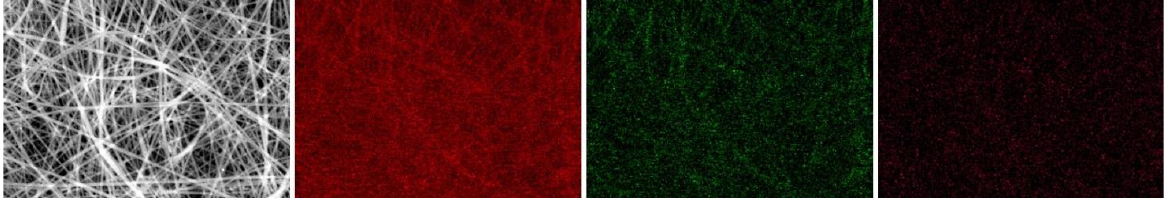
Figure 5. S E M-EDX images of PAN-PMMA fibers. The distribution of carbon atoms (in red), nitro- gen (in green), and oxygen (in purple) is shown.